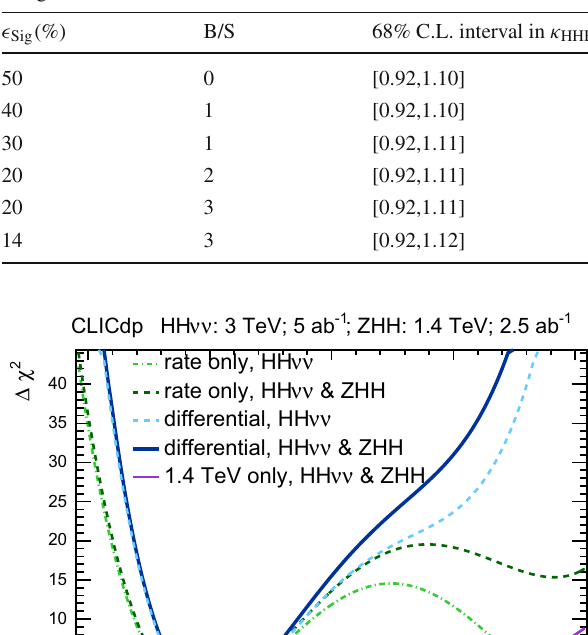
Table 8 Constraints on κ HHH in dependence on the assumptions for the performance of the ZHH analysis at 1.4TeV. The signal efficiency (cid:14) Sig and the ratio of selected events from background to signal, B/S, are varied. To obtain these constraints, the ZHH measurement is combined withthefullsimulationresultsfromtheHH ν ¯ ν analysesat1.4and3TeV, using differential information for HH ν ¯ ν at 3TeV